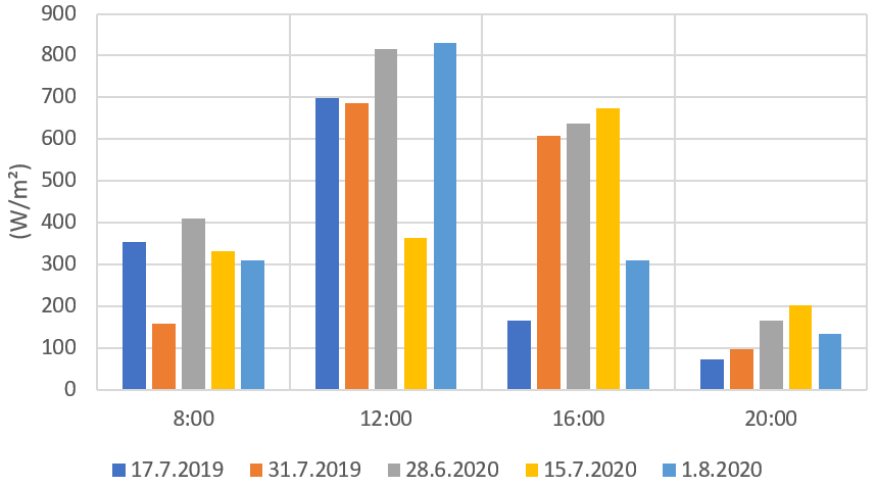
Figure 9. PYR radiation measurement results for each flight date.